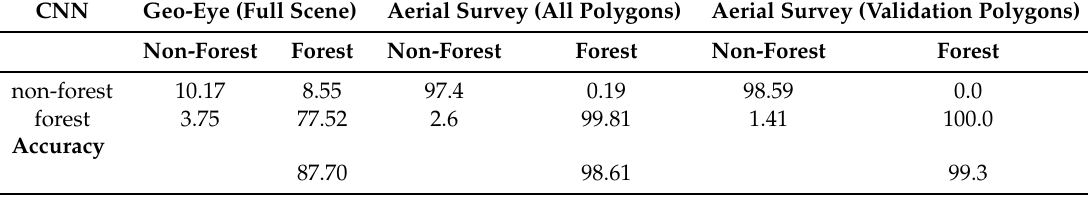
Confusion matrix showing % agreement between forest/non-forest classes using a Convolutional Neural Network (CNN) across previously selected homogenous areas: In addition, overall accuracy is reported for each confusion